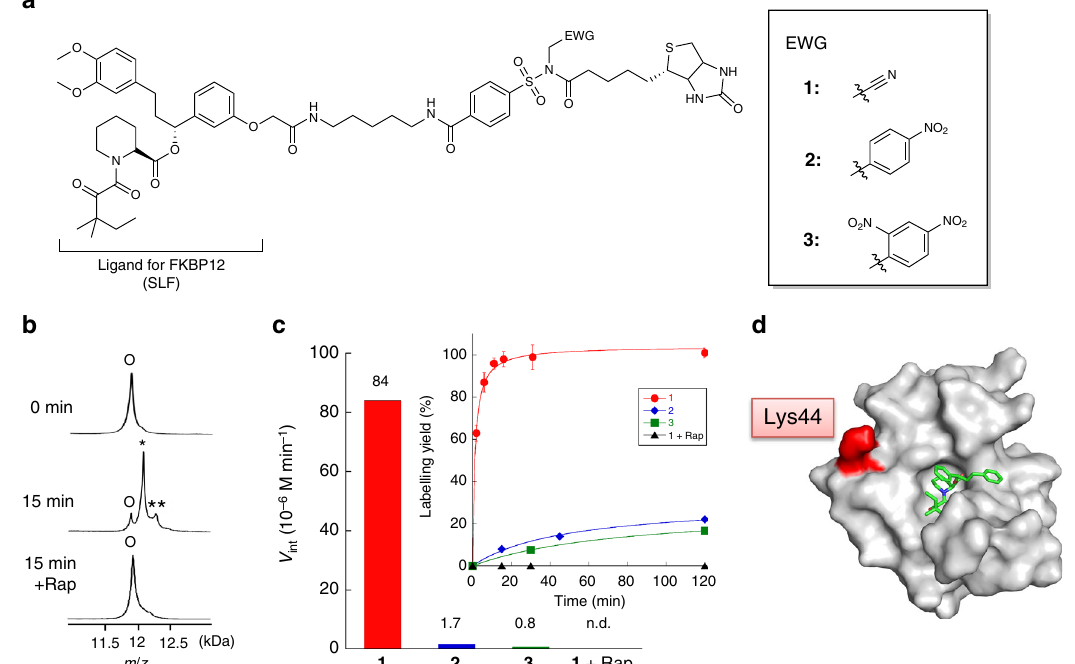
Fig. 2 In vitro FKBP12 labelling with LDNASA reagents 1 – 3 . a Molecular structures of LDNASA reagents 1 – 3 . b MALDI-TOF mass analysis of FKBP12 labelling by 1 in the absence or presence of rapamycin (Rap). Reaction conditions: 5 µ M FKBP12, 10 µ M 1 , 100 µ M Rap, 50 mM HEPES buffer, pH 7.2, 37 °C. o, native FKBP12 ( M w : 11 914); *, single-labelled FKBP12 ( M w : 12 140); **, double-labelled FKBP12 ( M w : 12 366). c Initial rates (M min − 1 ) of FKBP12 labelling by 1 – 3 . The initial rates were estimated from the time courses of the reaction yields (inset). n.d., not detected. d The crystal structure of the FKBP12-SLF complex (PDB:1FKG). Lys44, the major labelling site with 1 , is coloured in red. The SLF ligand is shown as a green stick. Lys34 was also identi fi ed as the second (minor) labelling site (see Supplementary Figure